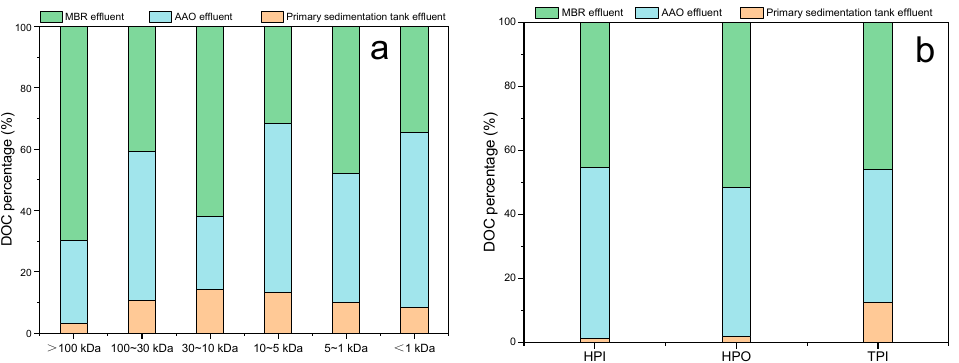
Figure 5. DOC percentage of various MW fractions ( a ) and hydrophobicity fractions ( b ) (HPI: hydrophilic fraction; HPO: hydrophobic fraction; TPI: transphilic fraction).